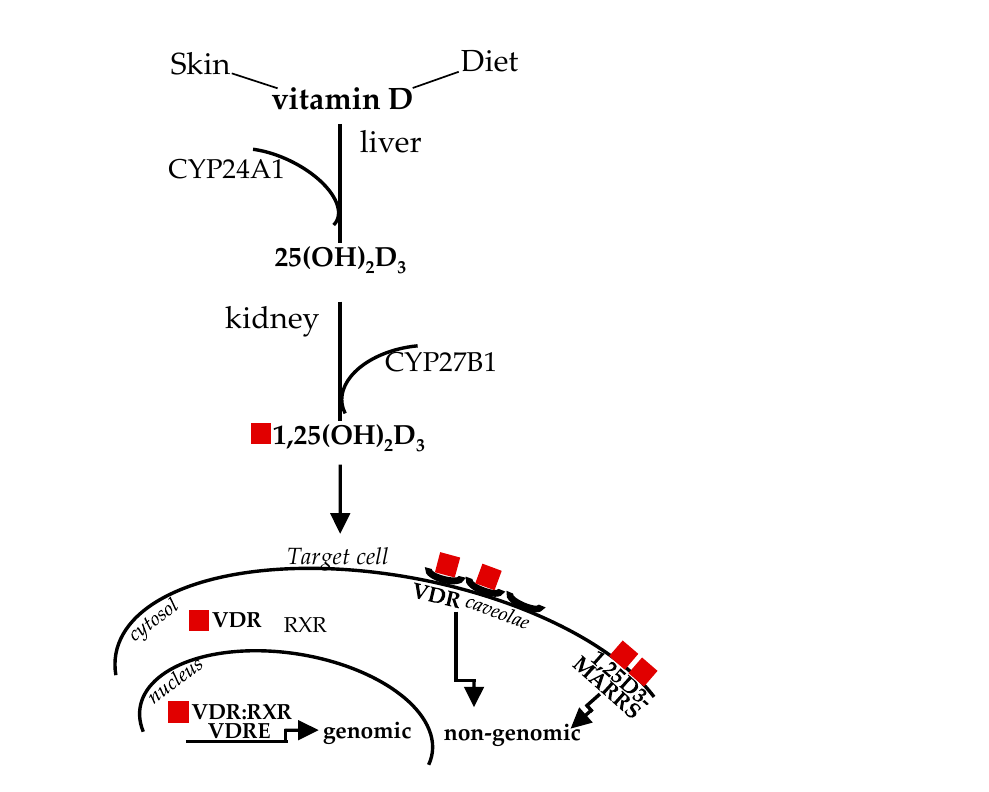
Figure 1. Vitamin D sources, metabolism and signaling. The active form of vitamin D derived by sun exposure or diet, after two enzymatic steps in the liver and kidney, binds to VDR in the cytosol to mediate genomic effects; alternatively, ligand binding, to caveolae-mediated or membrane- associated VDR, mediates rapid genomic responses. CYP24A1, D-25 hydroxylase; CYP27B1, D-1 hydroxylase; VDR, vitamin D receptor; RXR, with 9-cis-retinoic acid receptor; 1,25D3-MARRS, membrane-associated, rapid response steroid binding.